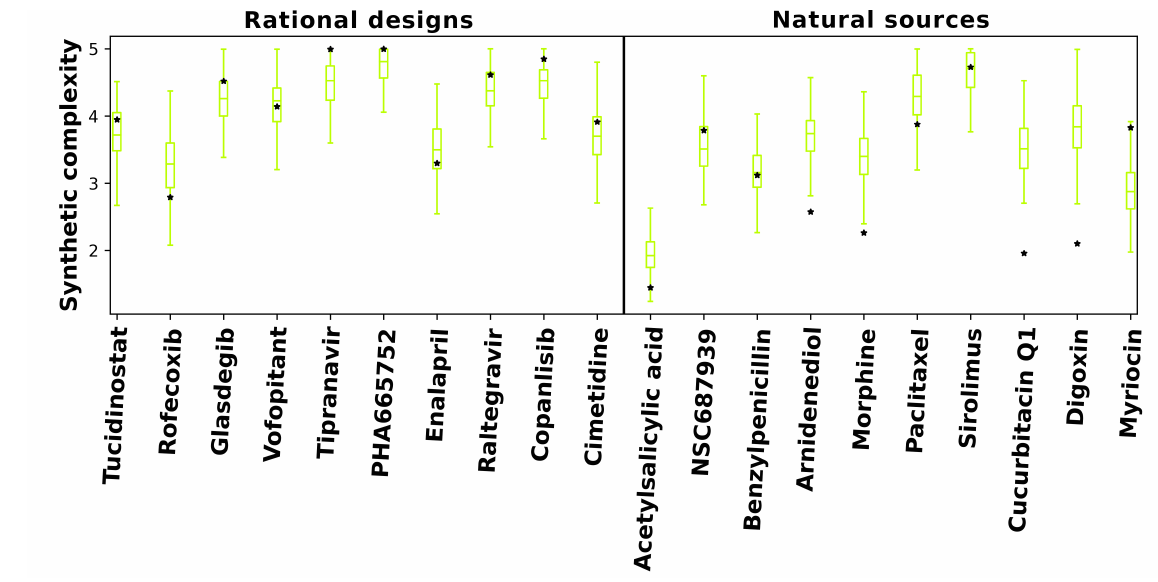
Figure 4. Predicted synthetic complexity of designs compared to objective compounds. Synthetic complexity scores for objective and RCVAE pipeline designed compounds as predicted by SCScore [56] serve as the basis for this comparison. Box plots denote the distributions of predicted synthetic complexity scores for RCVAE redesigns of objective compounds (stars). The scores of the objectives enable us to evaluate the synthetic feasibility of the redesigns relative to their corresponding objective compounds. There is a greater occurrence of low-scoring natural sources objectives in predicted synthetic complexity. This indicates that the SCScore software is biased by what is already well known or it may also highlight a potential reason why RCVAE performs better for objectives from the rational design subset: it is somewhat plausible that evolution optimizes for synthetic accessibility over binding free energies, hence the discrepancies in behavioral similarities between the designs and their objectives for the two benchmarking (rational design and natural sources) subsets (Figure 2). RCVAE designs are of similar synthetic complexity to their corresponding objective compounds as most objective complexities lie within the box plot whiskers (not outliers), with some designs being more accessible than their